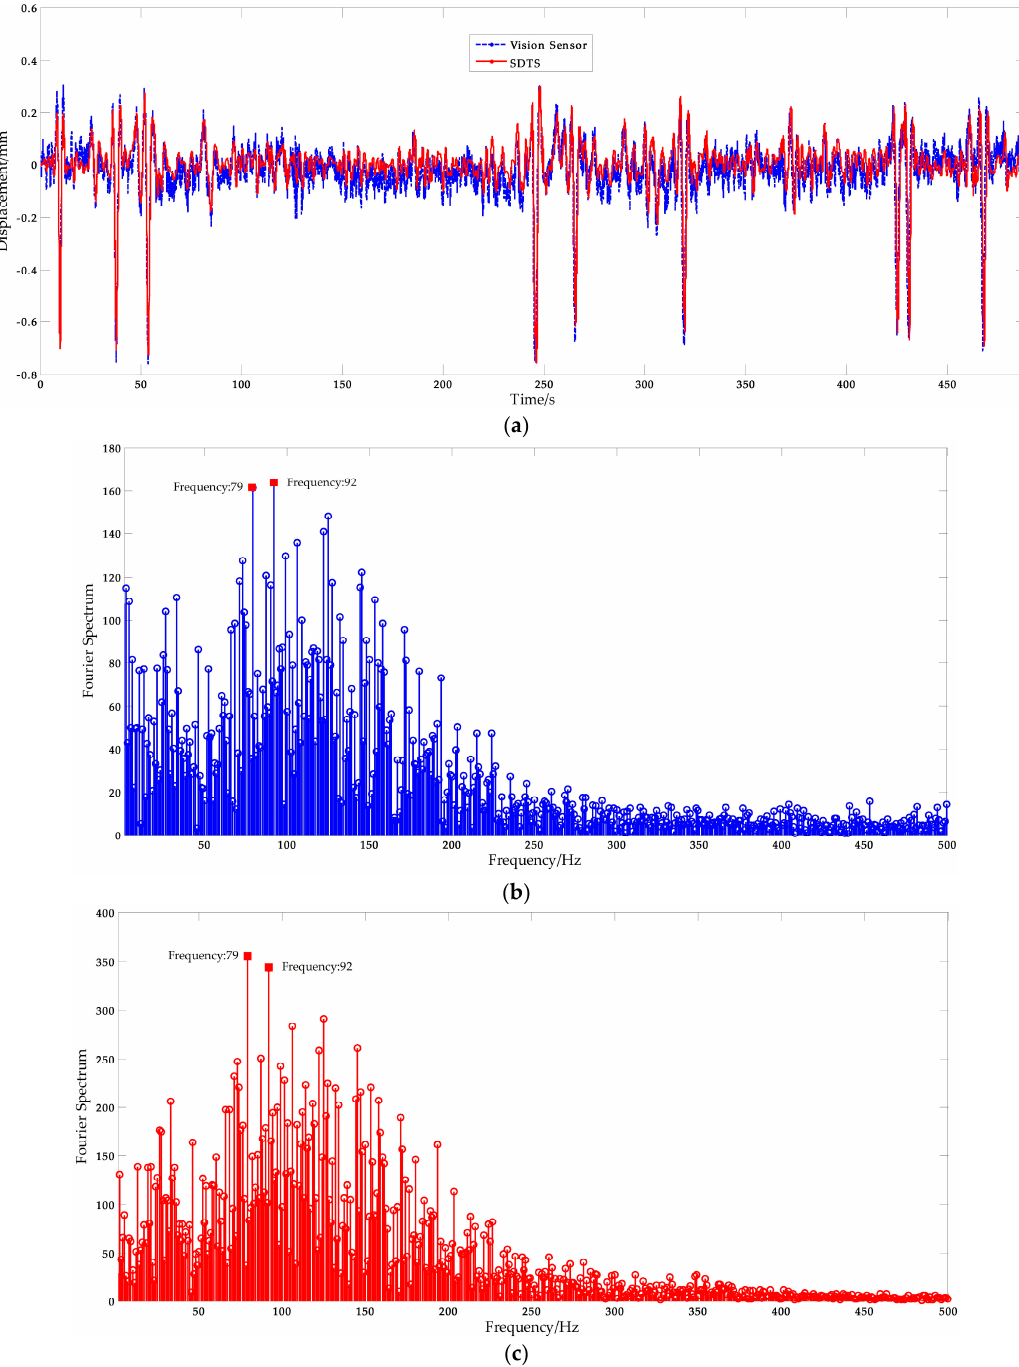
Figure 20. Free excitation of bridge: ( a ) Displacement measurement from the vision sensor and the STDS sensor; ( b ) and ( c ) the corresponding Fourier spectrum results.